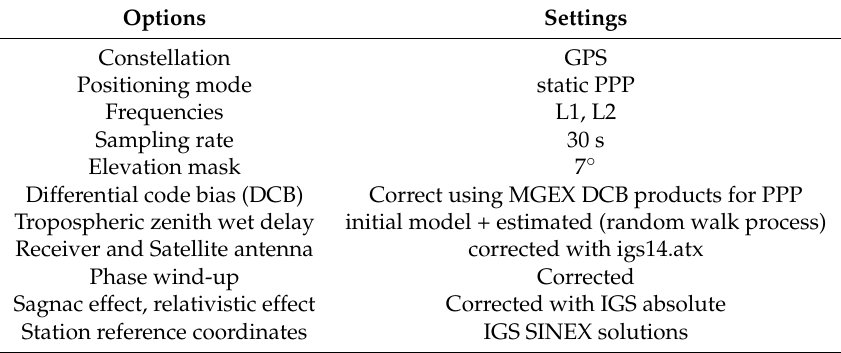
Table 2. Static PPP experimental